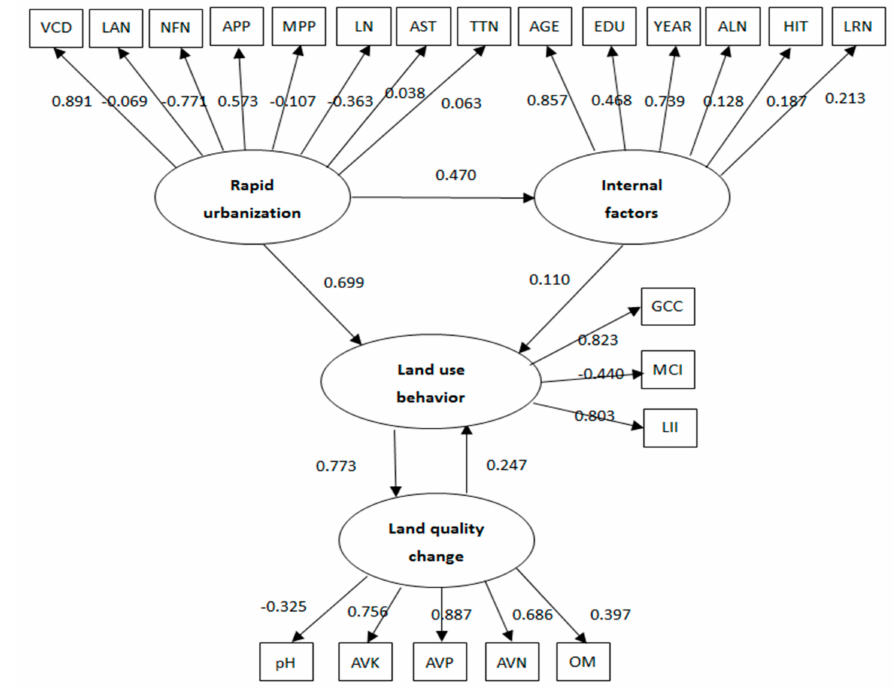
Figure 4. The structural equation diagram for urbanization-land use behavior-land quality